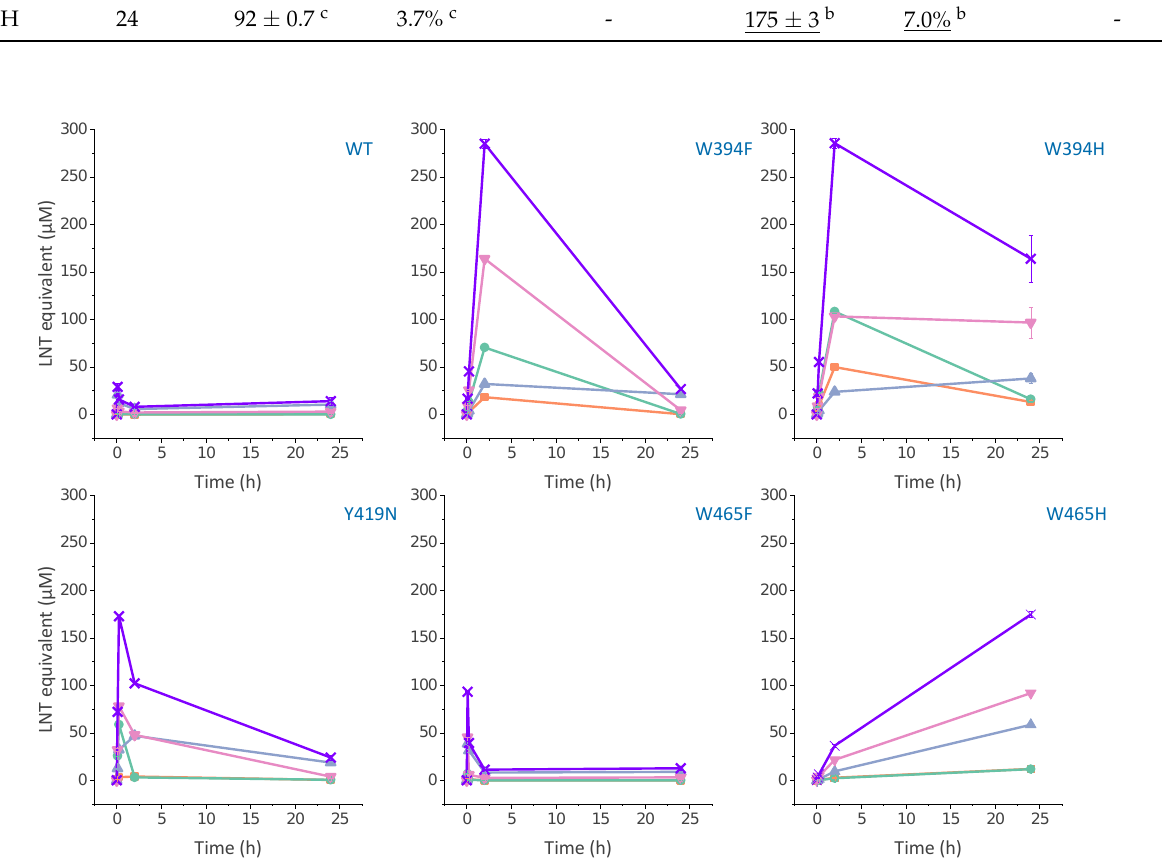
Figure 9. Transglycosylation reactions using pNP-LNB (2.5 mM) as donor and lactose (200 mM) as acceptor at pH 4.5 and 30 ◦ C for WT LnbB and the five best variants (W394F, W394H, Y419N, W465F, and W465H). The formation of trans-glycosylation products was followed over 24 h and quantified as LNT equivalents. Purple crosses represent the total formation of all LNT isomers, while pink triangles represent formation of LNT (LNB- β 1,3-Lac), orange squares LNB- β 1,2-Lac, green circles LNB-1,1-Lac, and blue triangles LNB- β 1,6-Lac.